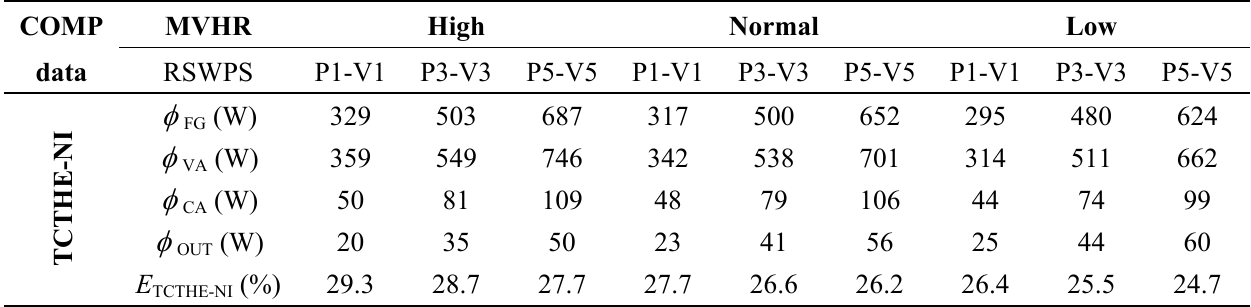
Table 7. Computed results of heat transfer rates and effectiveness within the TCTHE-NI. COMP MVHR High Normal Low data